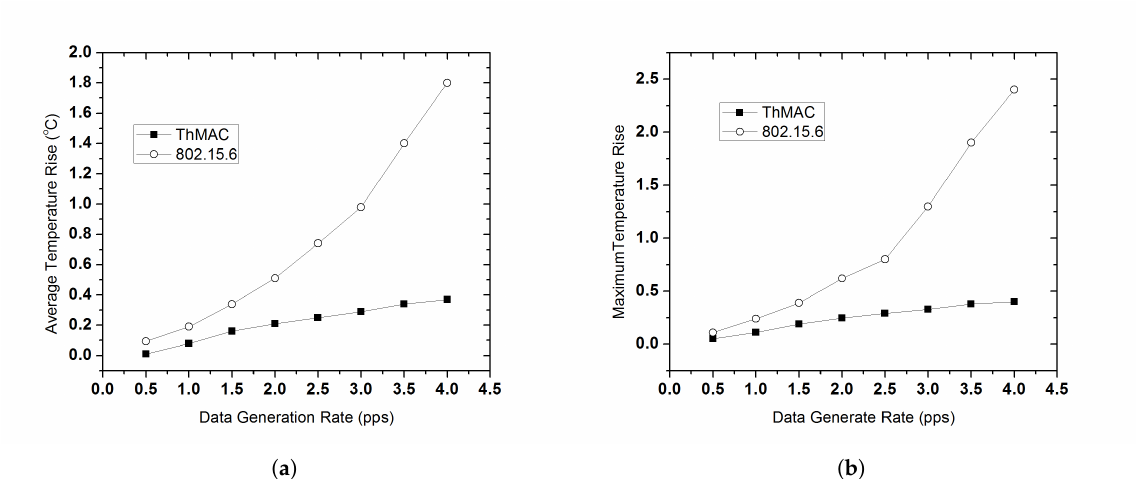
Figure 14. Thermal Performance. ( a ) Average Temperature Rise varying data generation rate. ( b ) Maximum Temperature Rise varying data generation rate.